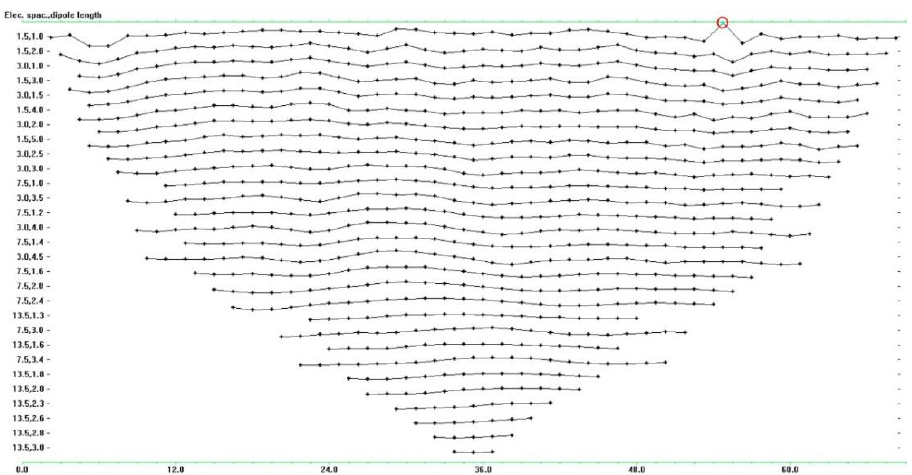
Figure 10. The distribution of bad data points (red circles) for the survey performed with the Wen-